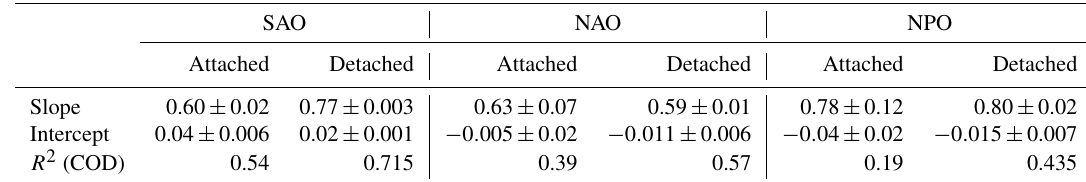
Table 6. Linear regression calculated between DRM SODA AOT 532nm and POLDER AOT 532nm for situations when the aerosol layer is attached to the cloud top and when the aerosol layer is well separated from the cloud over three regions (South Atlantic Ocean, North Atlantic Ocean and North Pacific Ocean) and for a period of 4.5 years. SAO NAO NPO Attached